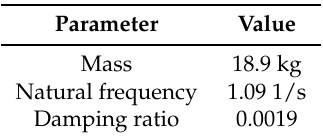
Table 3. Structure